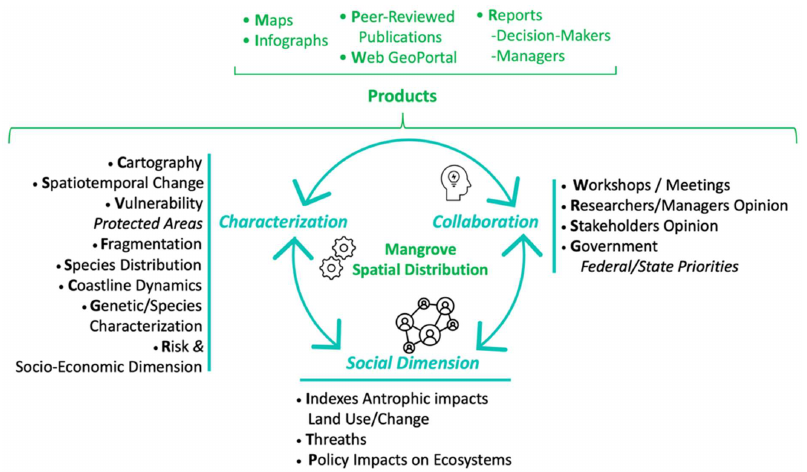
Figure 5. Interaction among the different phases included in the Mexican Mangrove Monitoring System (Spanish acronym: SMMM) and specific products based on the evaluation of the periodic mangrove spatial distribution assessment (see Figure 3).